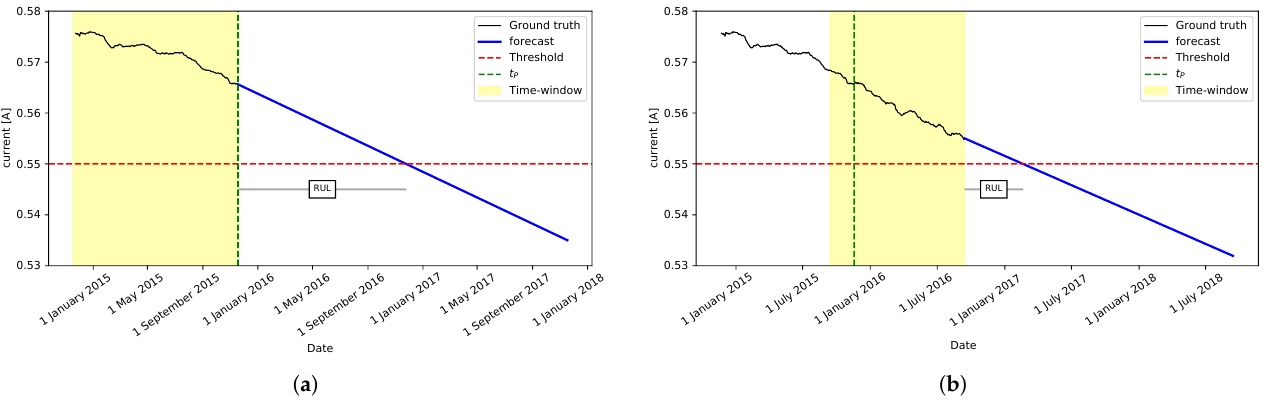
Figure 5. An example of RUL estimation using a time-window size of 365 days. ( a ) Time-window samples until fault date t P . ( b ) Time-window shifted by 300 days.